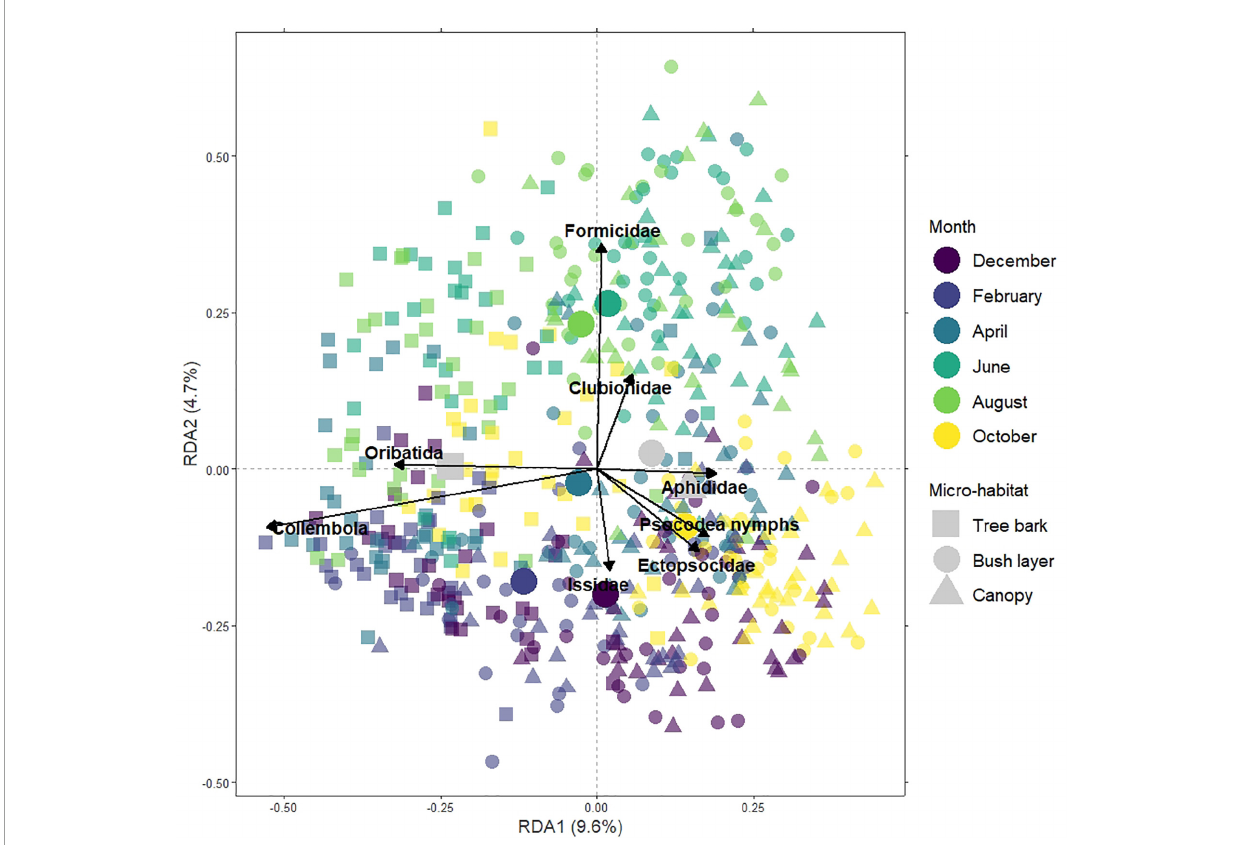
FIGURE4 Triplot representing the 1st (RDA1) and 2nd (RDA2) components of the redundancy analysis on the full dataset. The sites (i.e., the micro-habitat at each 180 location within Innsbruck urban mosaic) are ordered based on their taxonomic composition. Different symbol colours highlight clusters by months, while different symbol shapes highlight clusters by micro-habitat. The main taxonomic groups explaining the ordination are highlighted by vectors. The large plain circles show the centroid for each month while the large grey shapes show the centroid for each